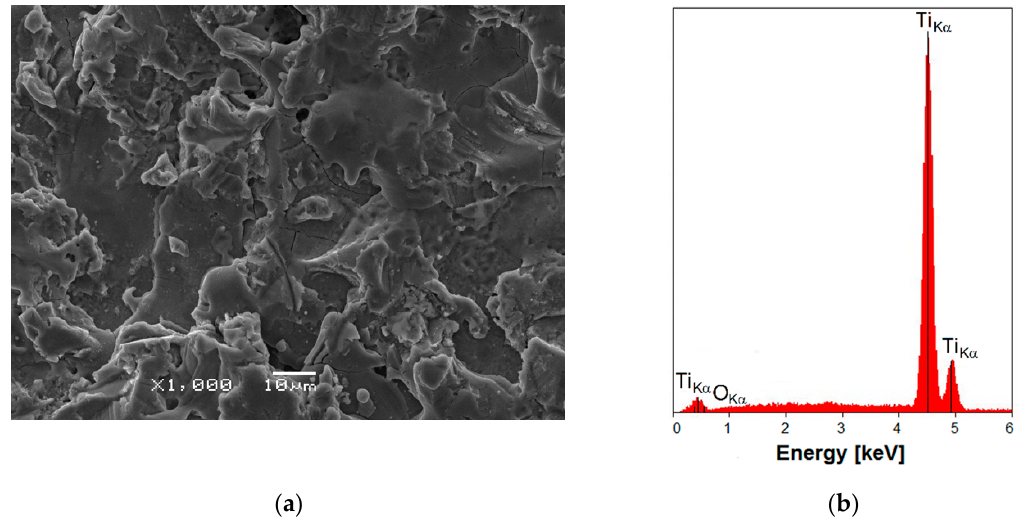
Figure 3. ( a ) SEM image of the Ti G4 machine surface after sandblasting; ( b ) EDS spectrum in the micro-region of the sandblasted surface. micro-region of the sandblasted